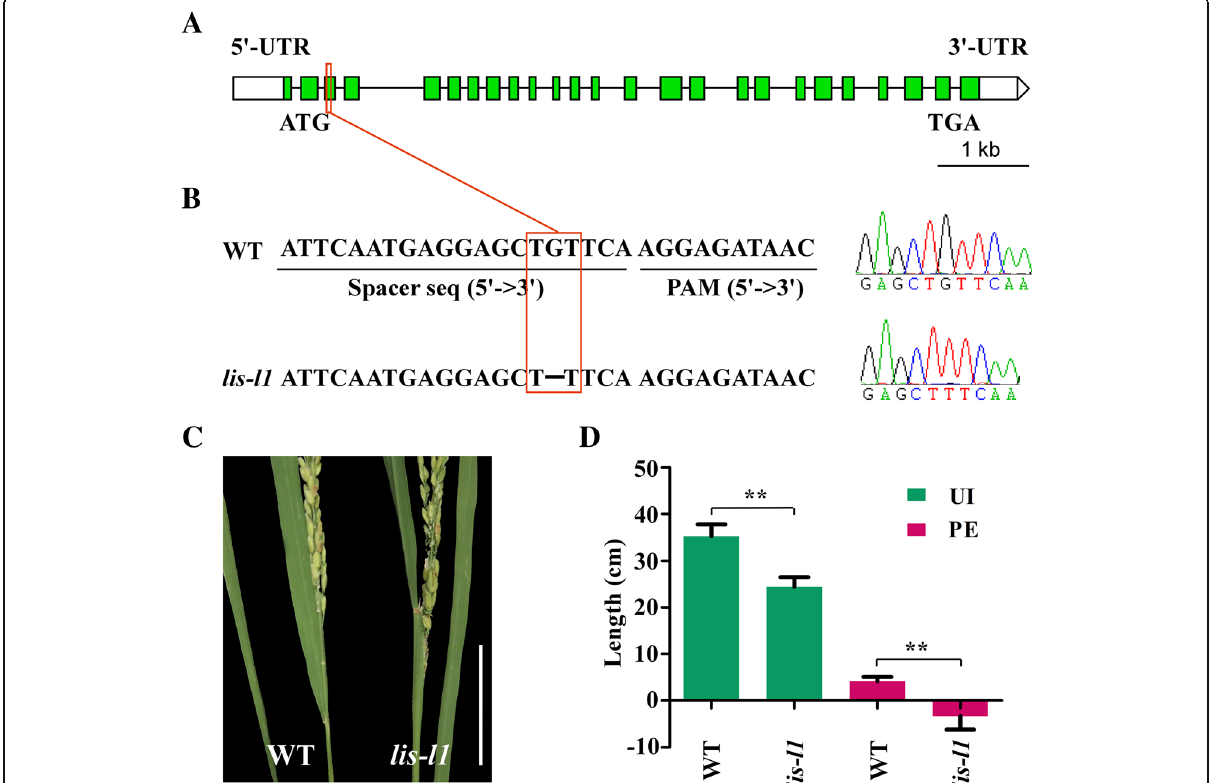
Fig. 6 Identification of OsLIS-L1 as the causal gene for qPE19. a Schematic presentation of the gene structure of OsLIS-L1 and b deletion sites in oslis-l1 mutants using the CRISPR/Cas9 system. c , d PE and UI of WT and oslis-l1 mutants. ** indicates a significant difference compared to WT at the 1%